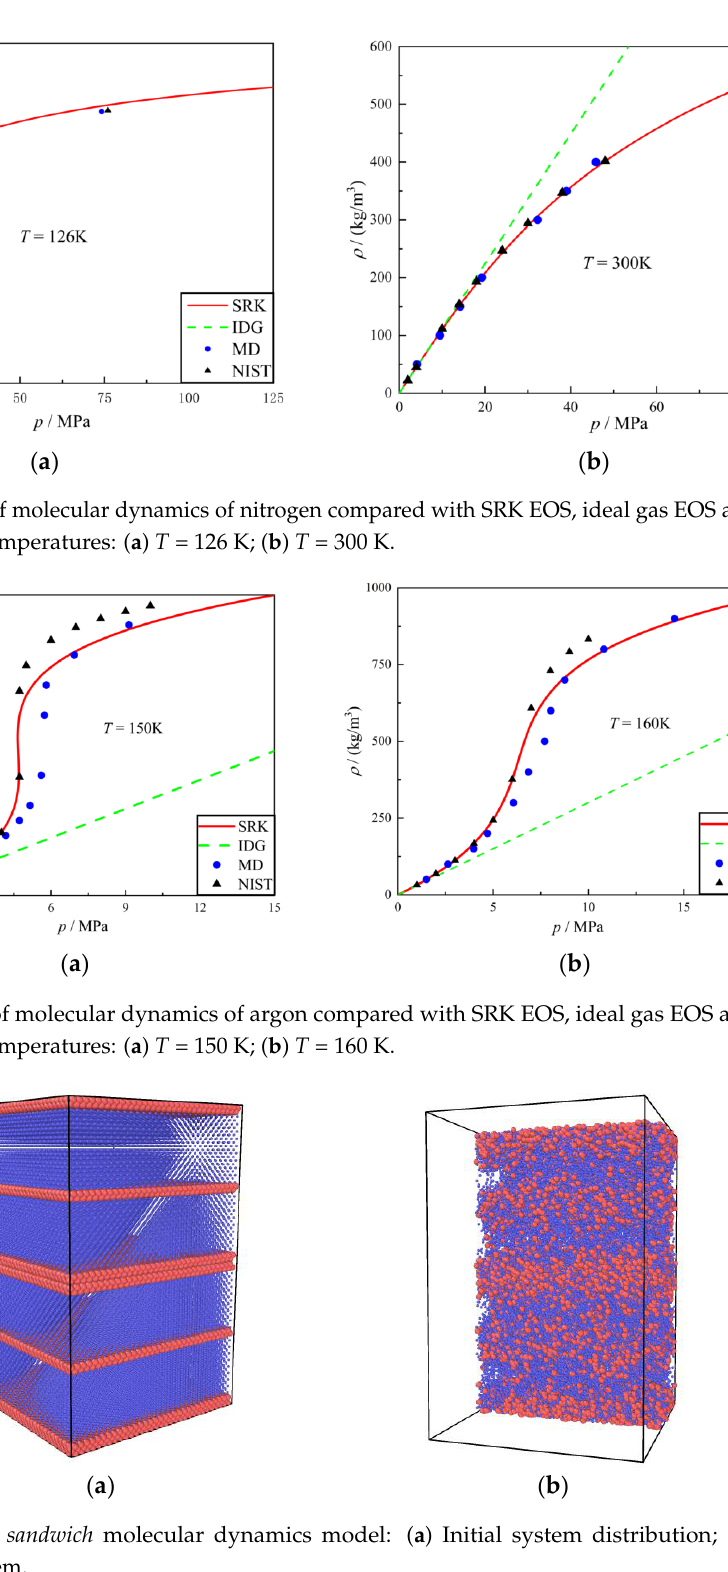
Figure 6 . Nitrogen model made by molecular dynamics: ( a ) initial nitrogen distribution; ( b ) well- proportioned nitrogen.